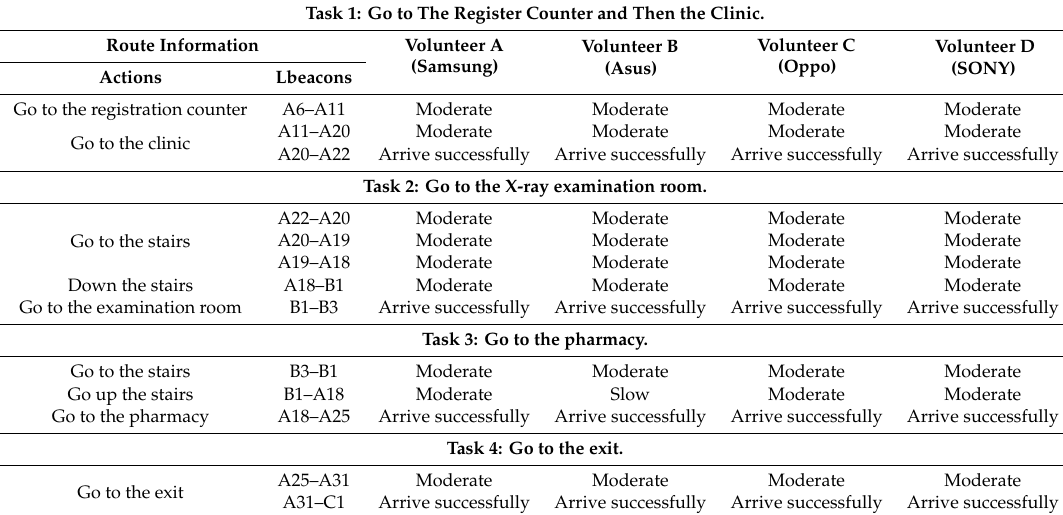
Figure 14. The installation of Lbeacons in the outpatient area of NTUH-Yunlin. Table 4. The volunteers’ feedback on